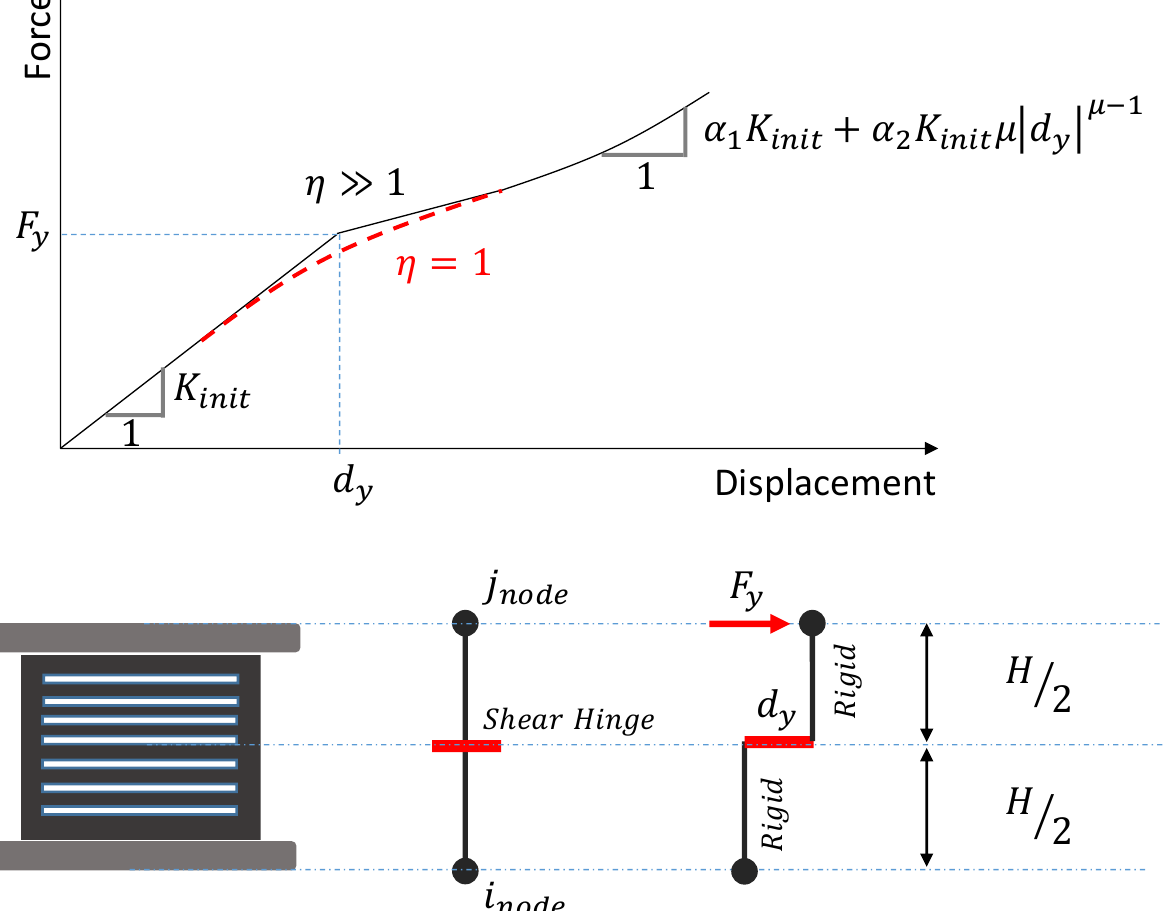
Figure 3. Spring model representation of the Elastomeric Bearing (Bouc – wen) Element.